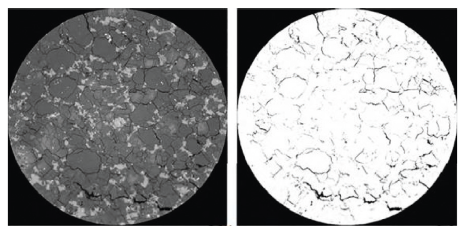
Figure 5: Cross-sectional gray CT